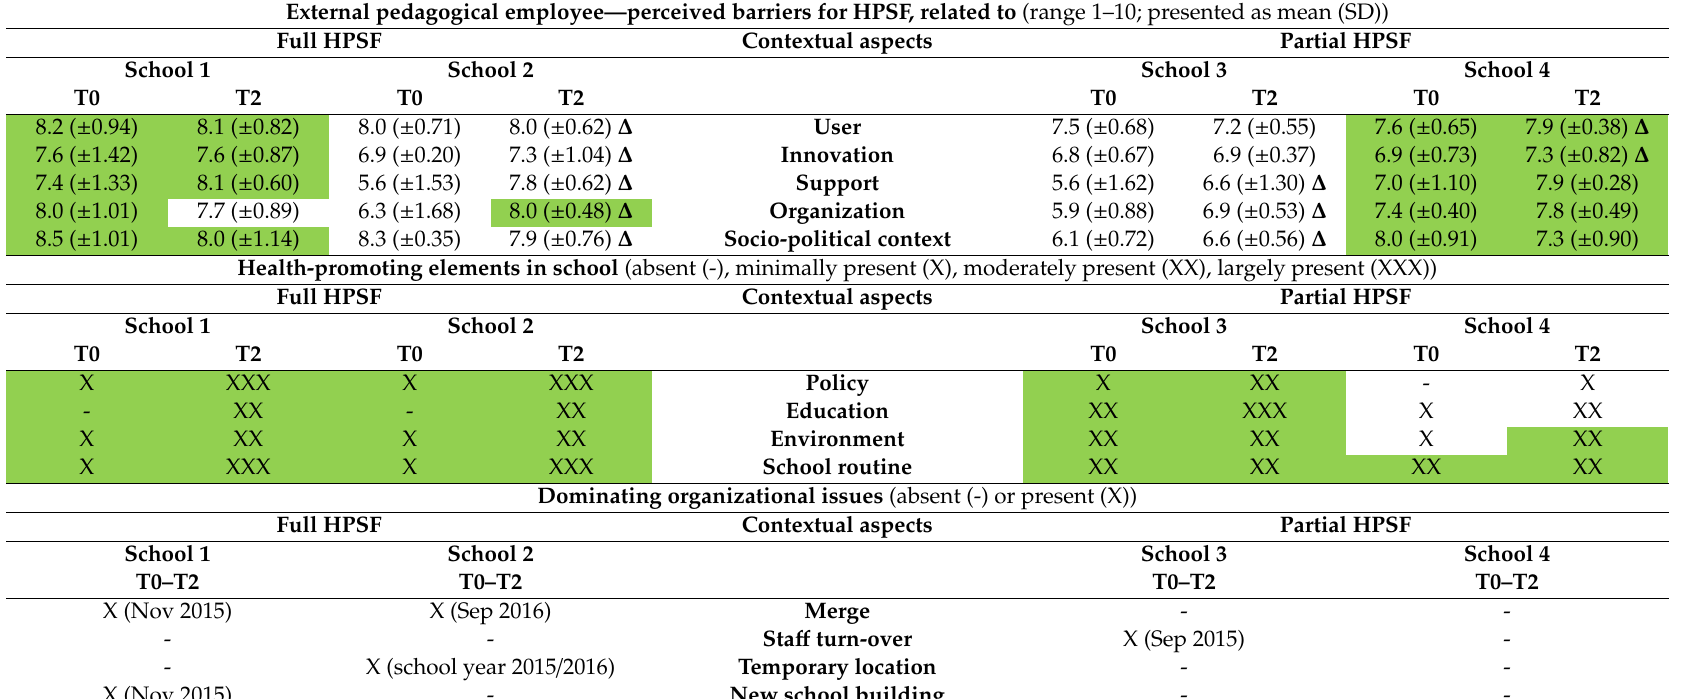
External pedagogical employee—perceived barriers for HPSF, related to (range 1–10; presented as mean